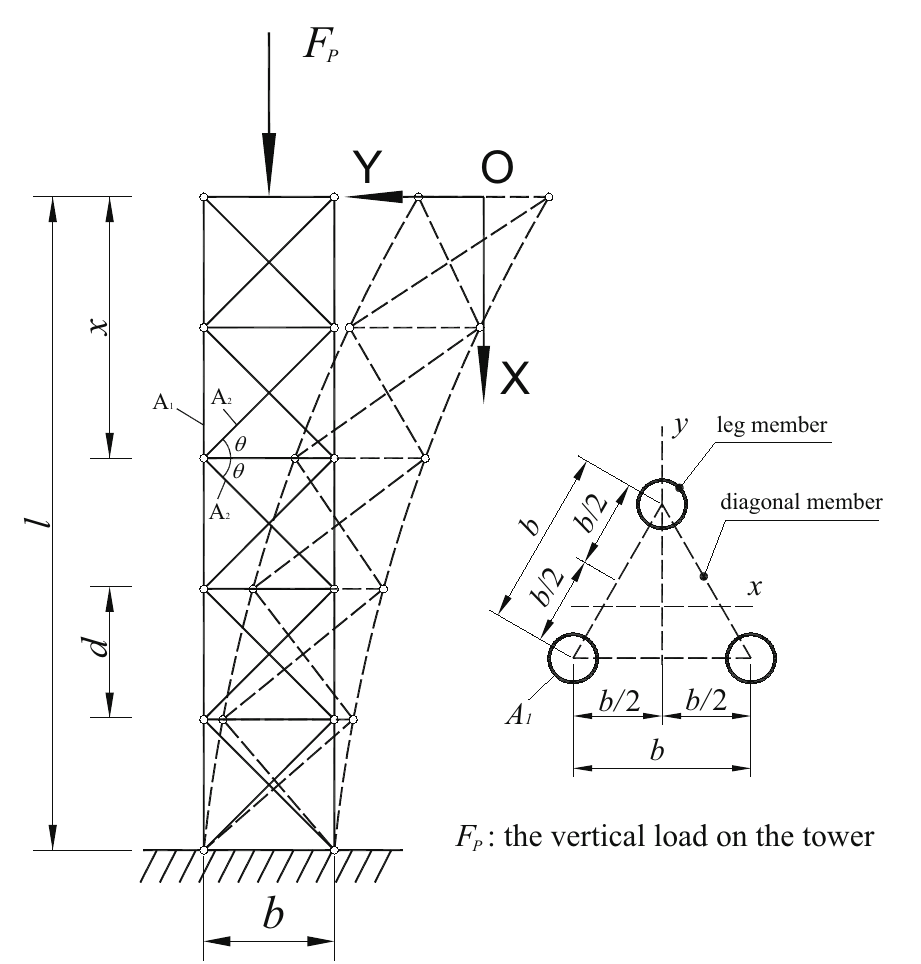
Figure 1. The triangular lattice